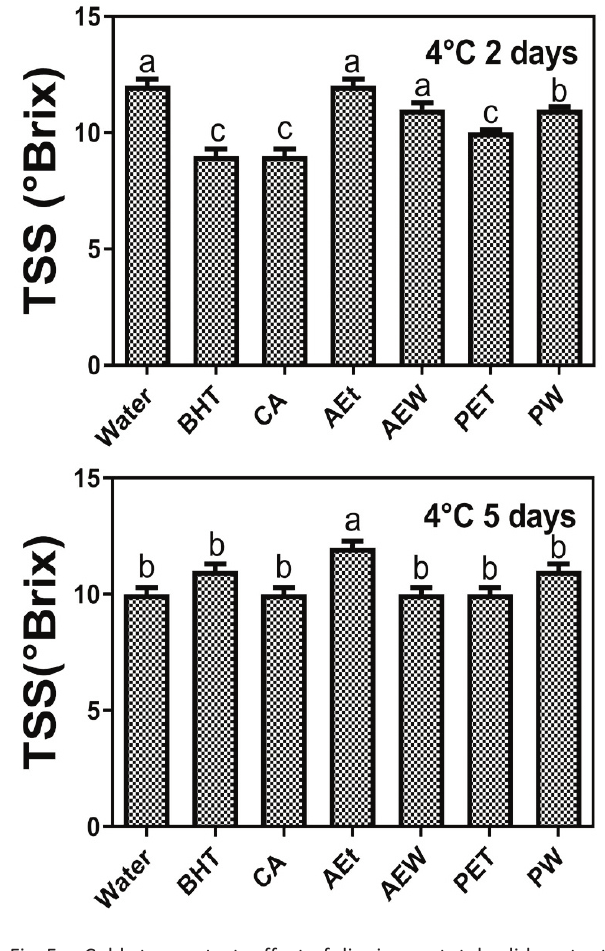
Fig. 5 ­ Cold storage test: effect of dipping on total solid content (TSS) expressed as °Brix of fresh­cut apples determined at 4°C after 2 and 5 days from dipping treatments: water; BHT (1% butylated hydroxytoluene); CA (1% citric acid); EtA (10% ethanol apple extract); WA (water apple extract); EtP (10% ethanol potato extract); WP (water potato extract). Data are means ± SE. Different letters indicate significant statistical difference at